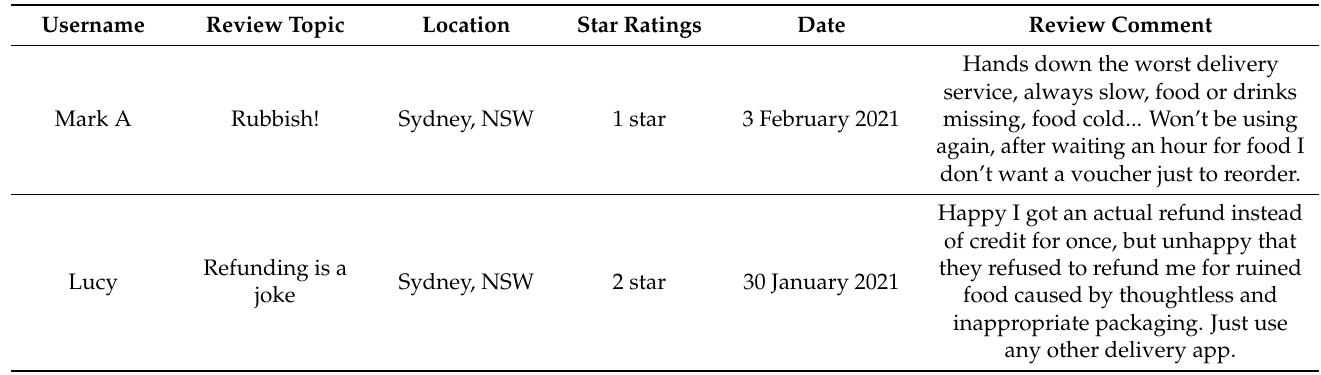
Table 1. Different attributes of the dataset from